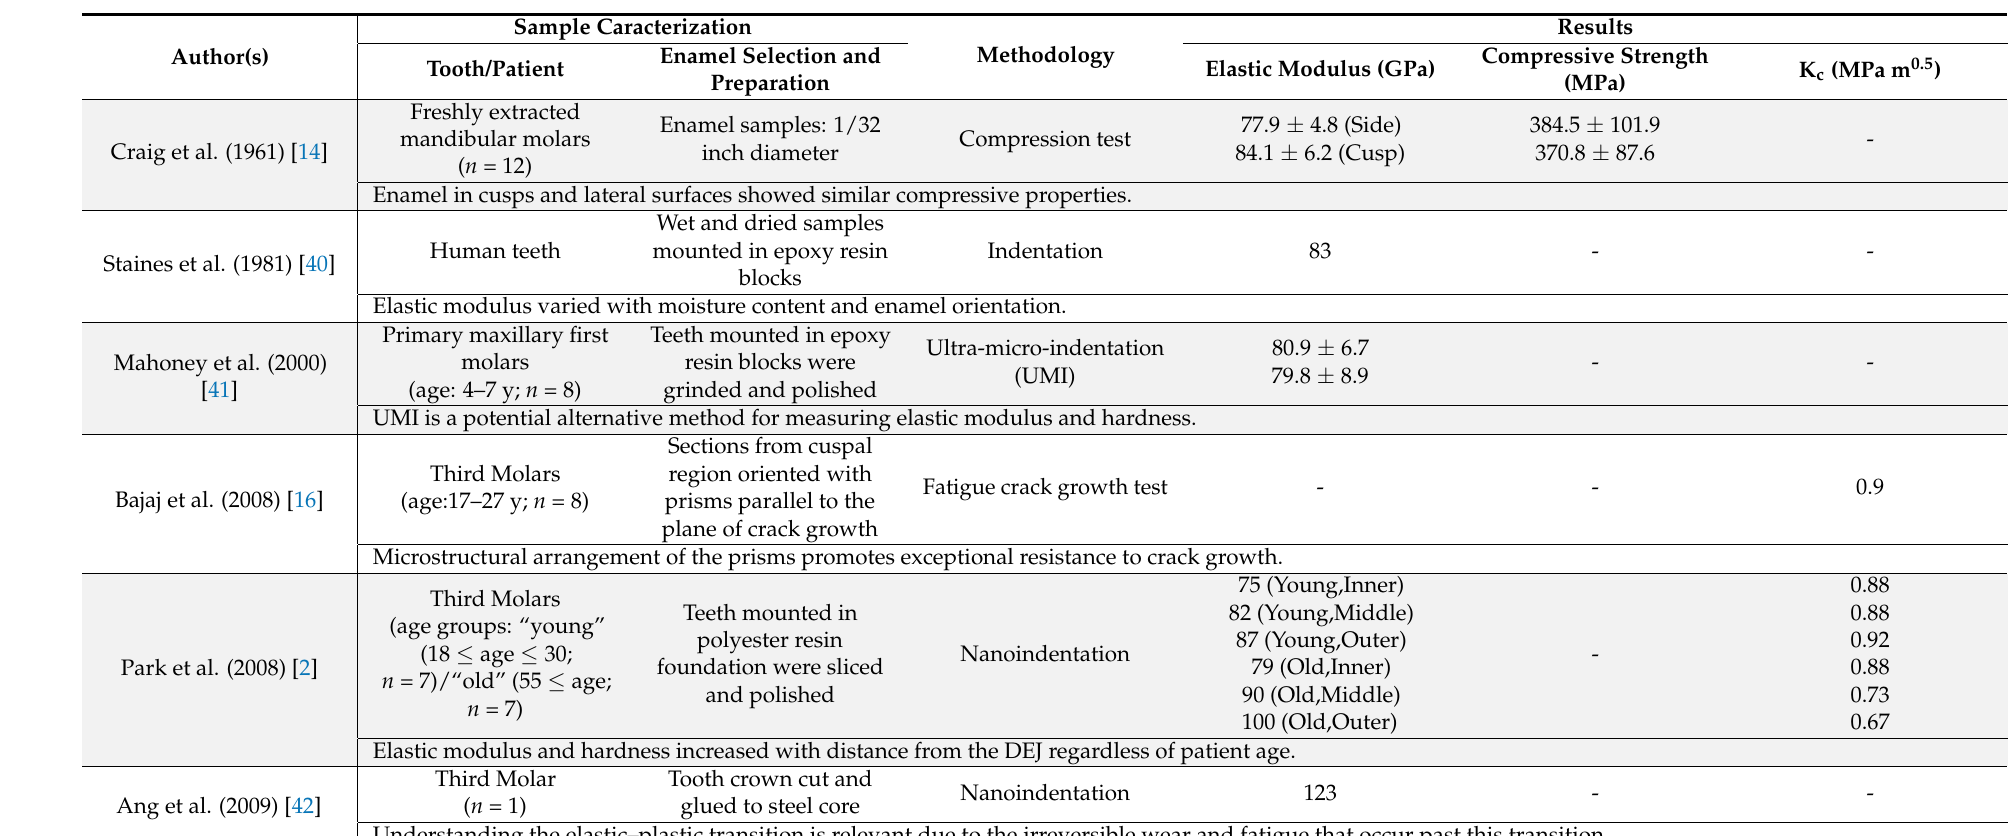
Table 1. Enamel Mechanical Properties: sample characterization, methodology used and results obtained from the different